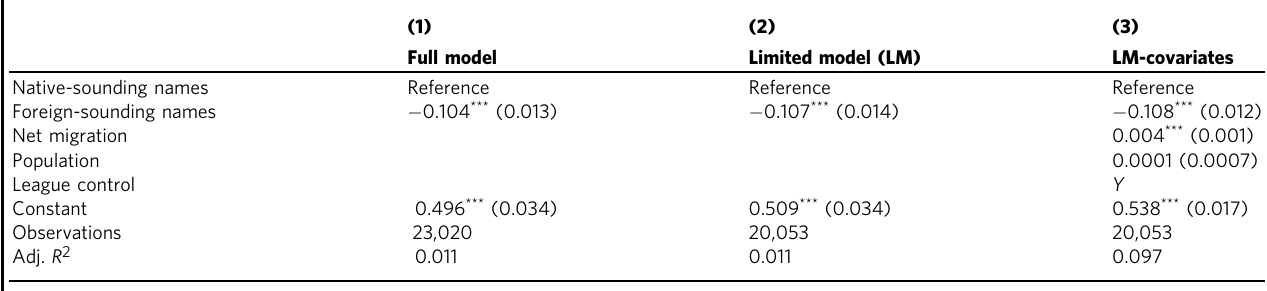
Table 2 Regression